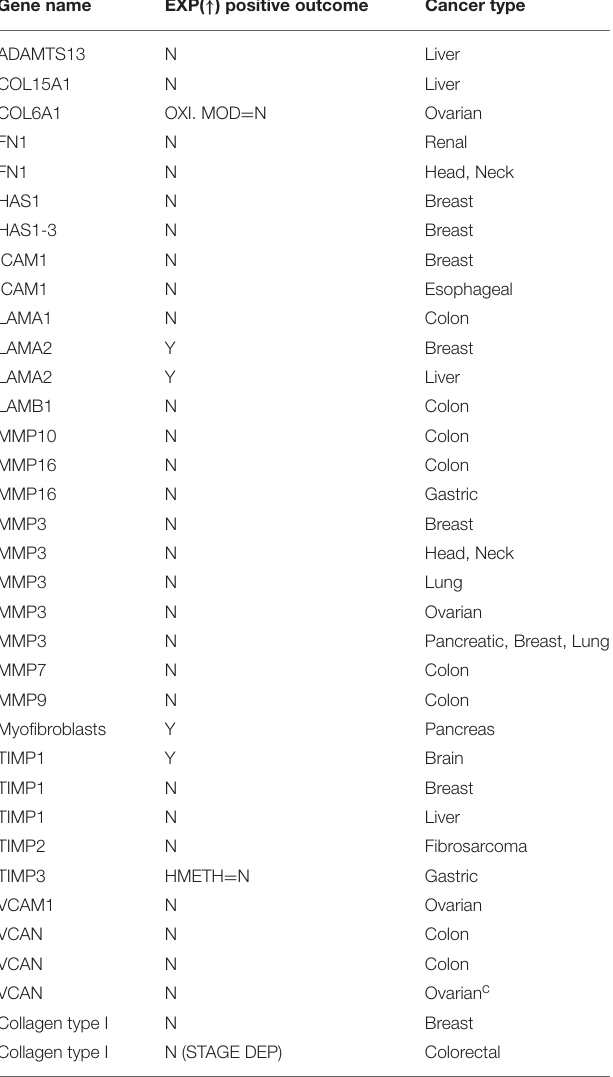
TABLE 4 | ECM-associated genes used as primary keywords in search parameters a